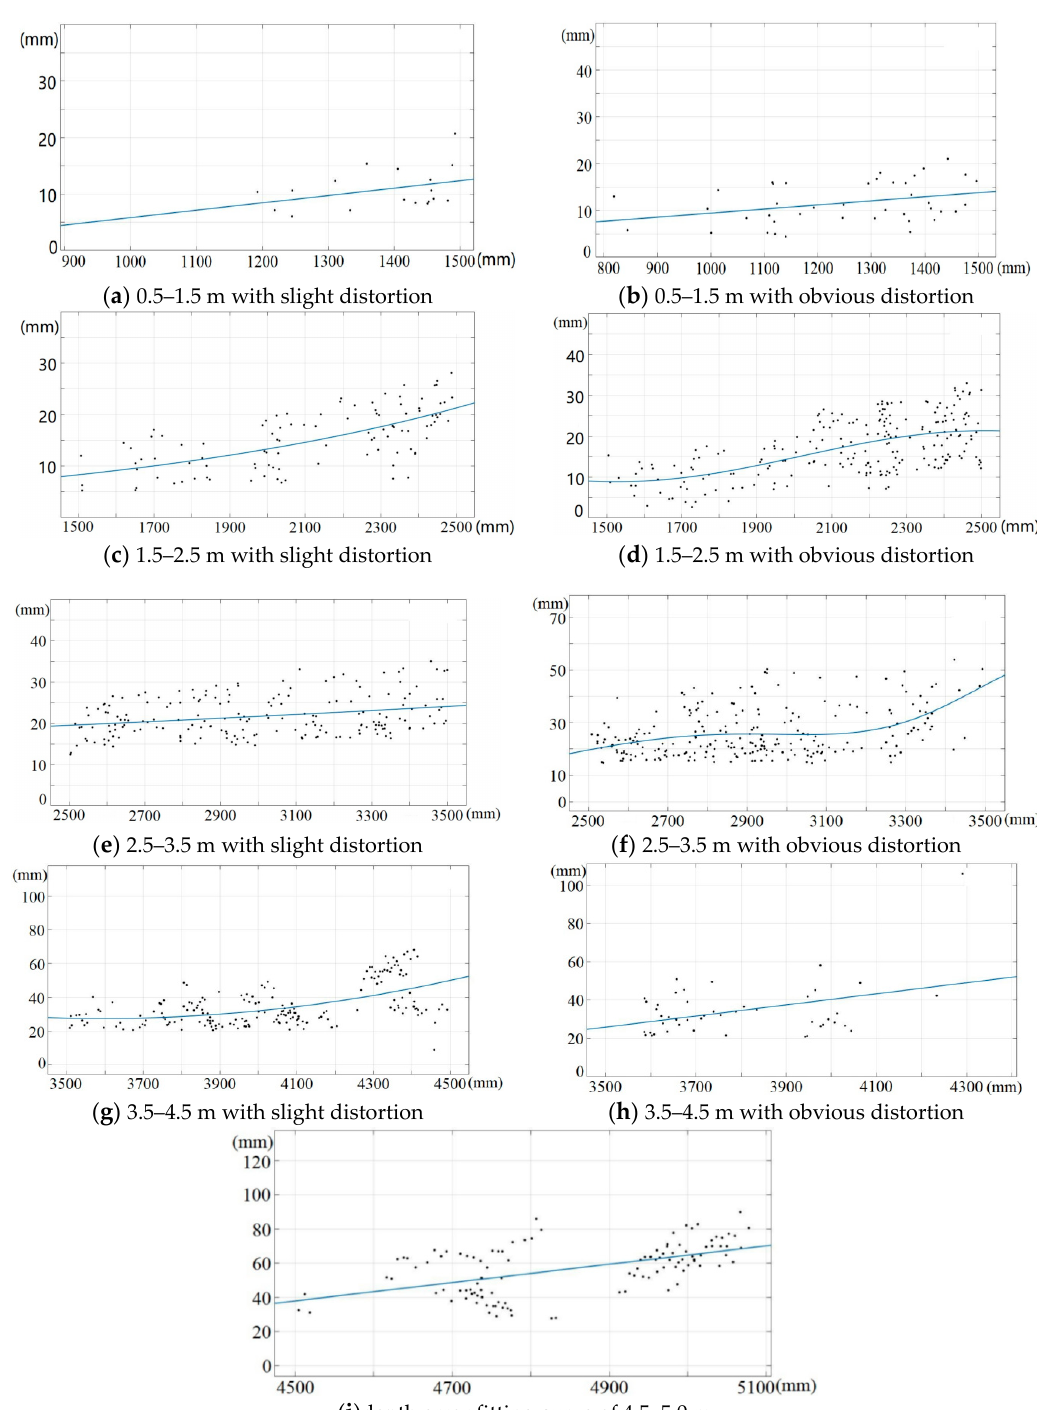
Figure 10. The results of fitting depth error combining with pixel distortion.